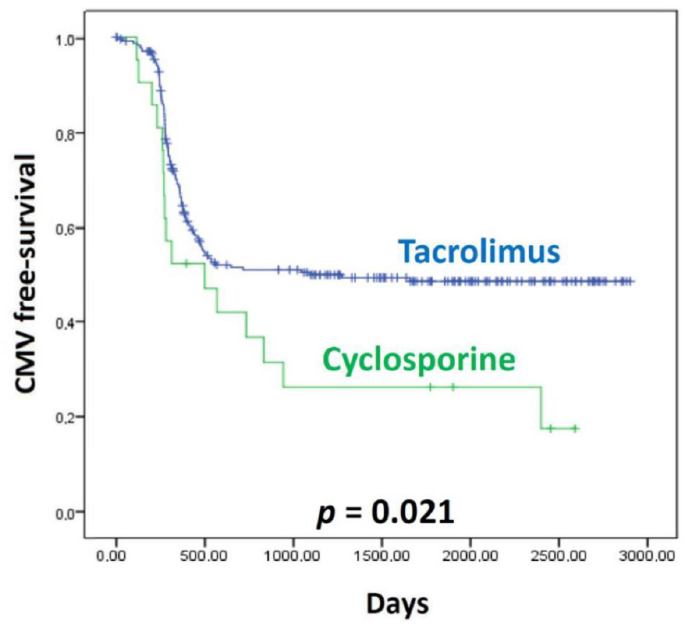
Figure 3. Immunosuppressant drug. The CMV infection rate was lower in the group of patients treated with tacrolimus ( p = 0.021).